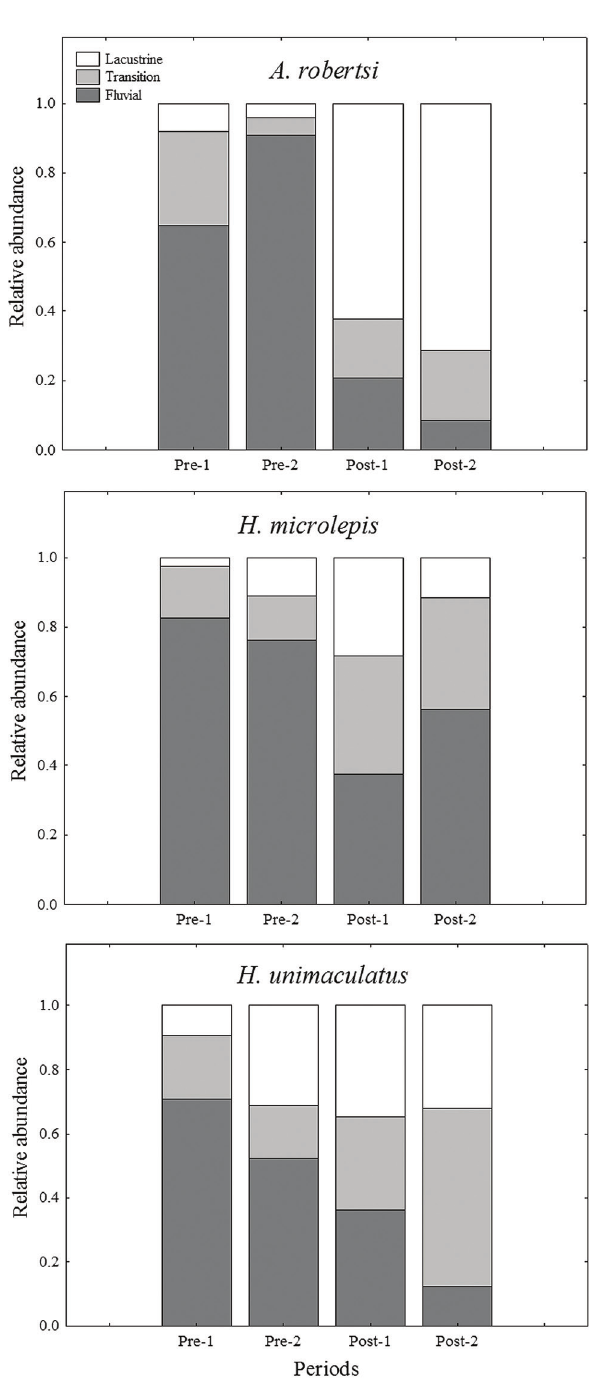
Fig. 1. Relative abundance of A. robertsi , H. microlepis , and H. unimaculatus in Pre- and Post-impoundment periods, in sites distributed along the reservoir (combined within zones: Fluvial, Transition, and